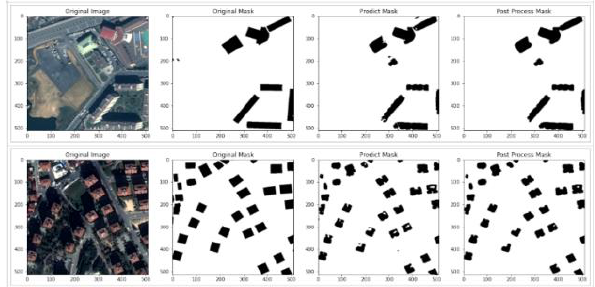
Figure 7 . Post processing results on sample images from the CSCRS Istanbul Building dataset.